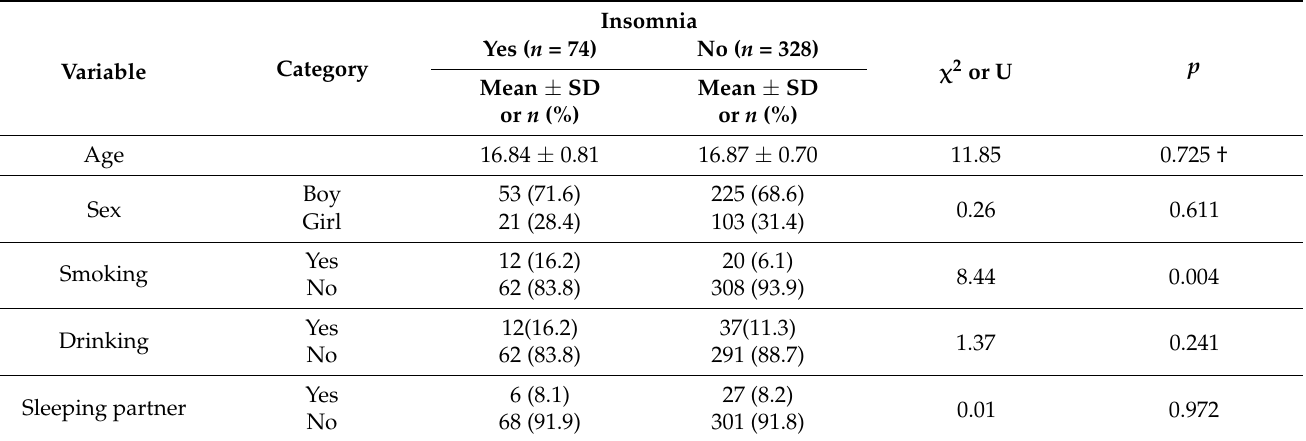
Table 4. Comparison of characteristics between insomnia and non-insomnia groups ( n =